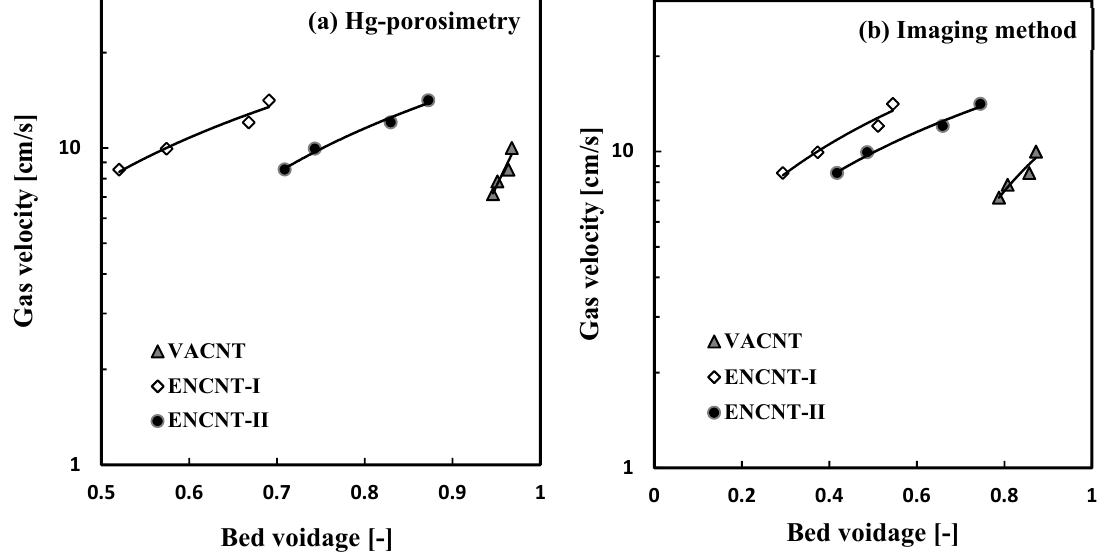
Figure 12. Bed expansion behavior ( a , b ) fitted with the Richardson-Zaki equation.